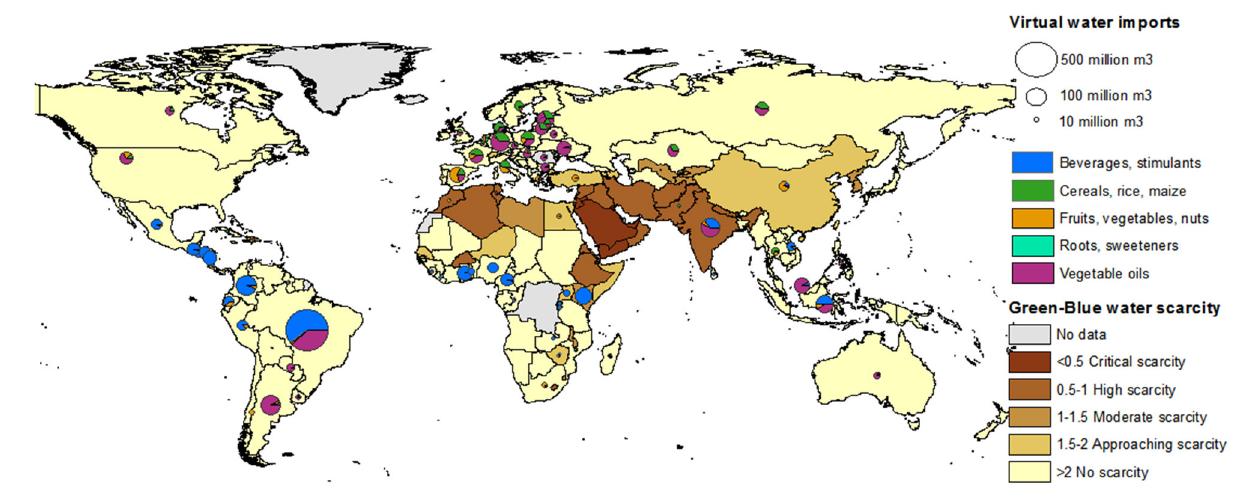
FIGURE 3 | Map of combined green and blue water scarcity (=the availability of green and blue water/requirements in a region, Kummu et al., 2014) and green and blue water embedded in crop imports to Finland (mean of 2007–2011). The size of the pie charts represents the volume of green and blue water imported into Finland and they are sized proportionally by